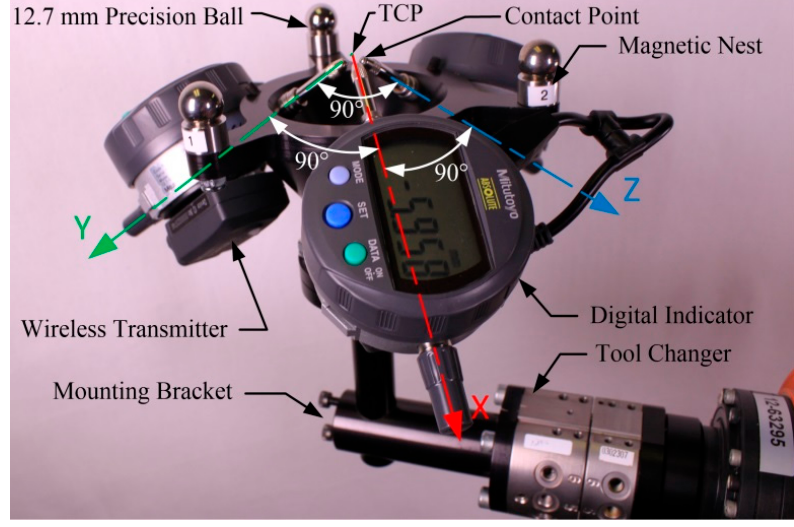
Figure 1. The proposed 3D measuring device.